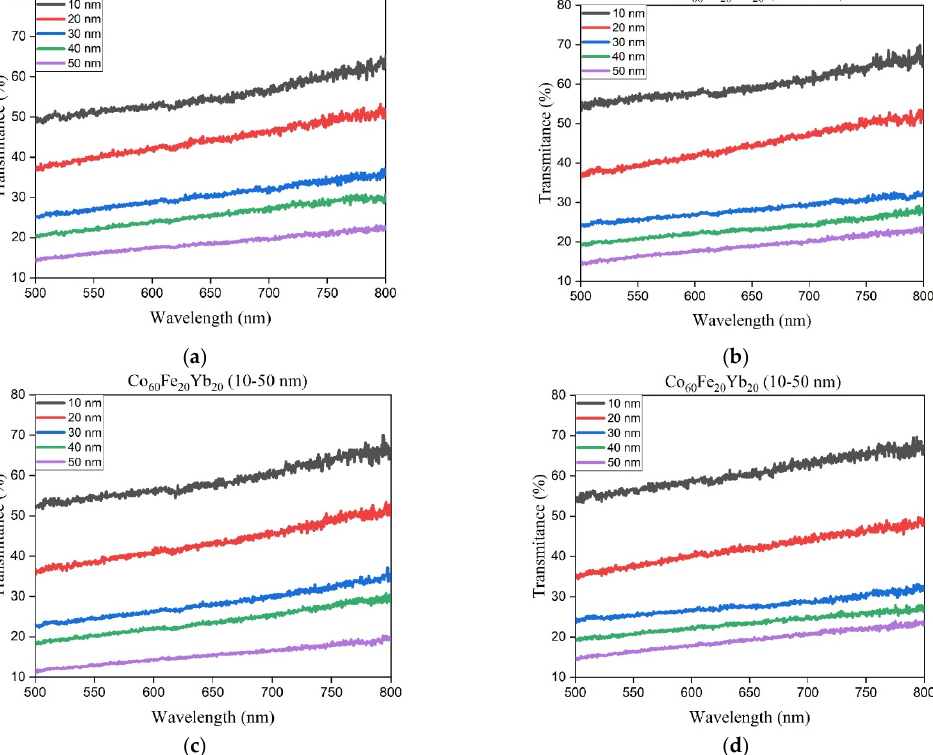
Figure 8. Transmittance of CoFeYb thin films. ( a ) RT, ( b ) following annealing at 100 °C, ( c ) following annealing at 200 °C, and ( d ) following annealing at 300 °C.